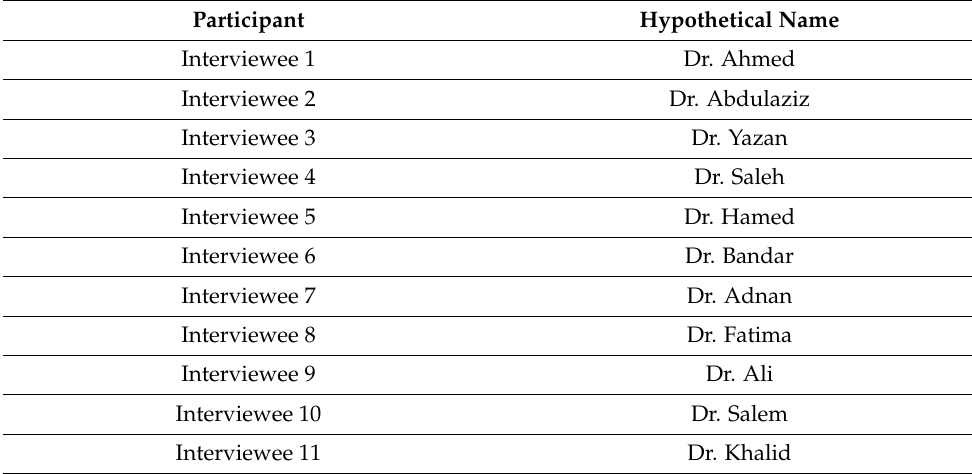
Table 1. Interviewees